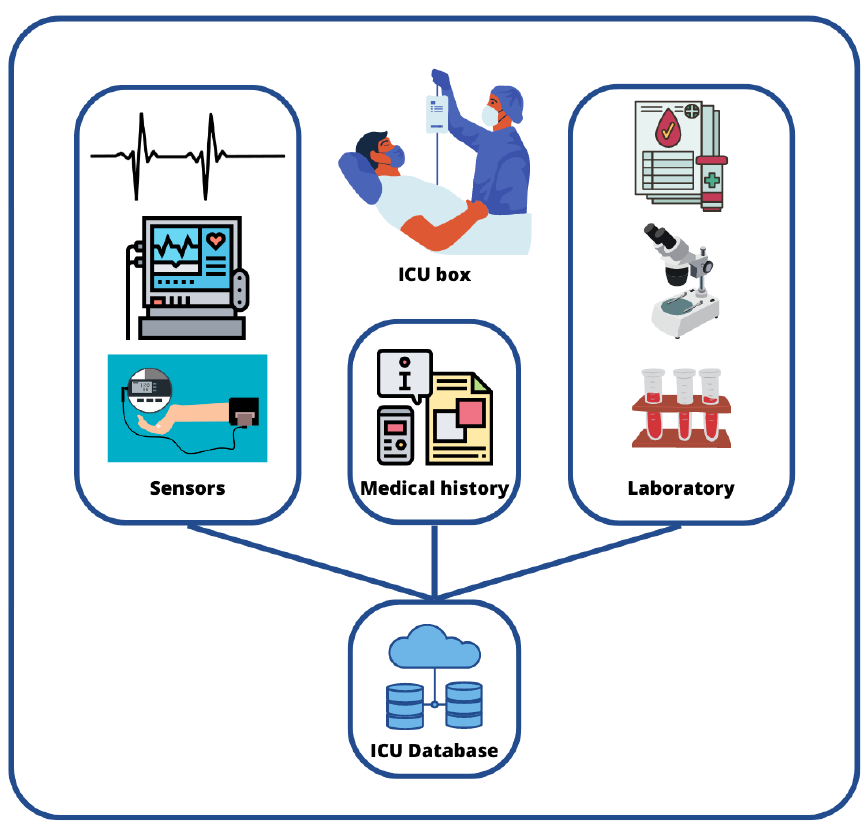
Figure 1. Intensive care unit